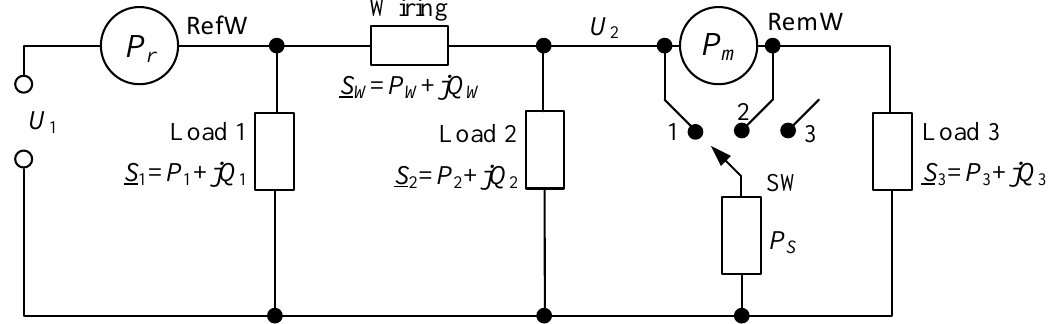
Figure 3. A network model for the explanation of the remote wattmeter adjustment gain estimation procedure.